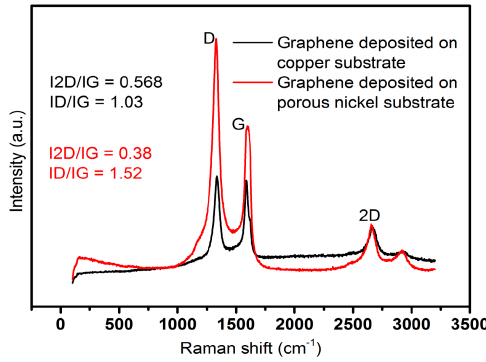
Figure 1. Raman spectra of graphene nanosheets deposited from methane on copper and from bagasse on porous nickel substrates. on porous nickel